Question: Identify the chart type used in this figure.
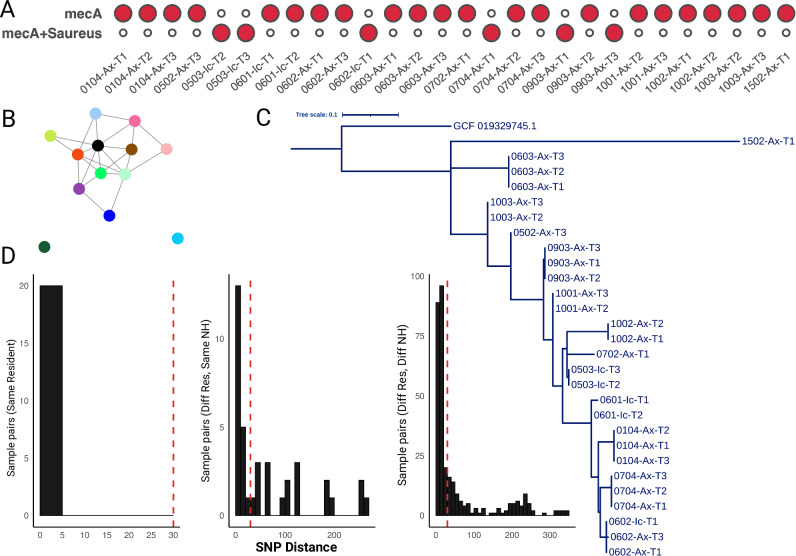
Answer: histogram